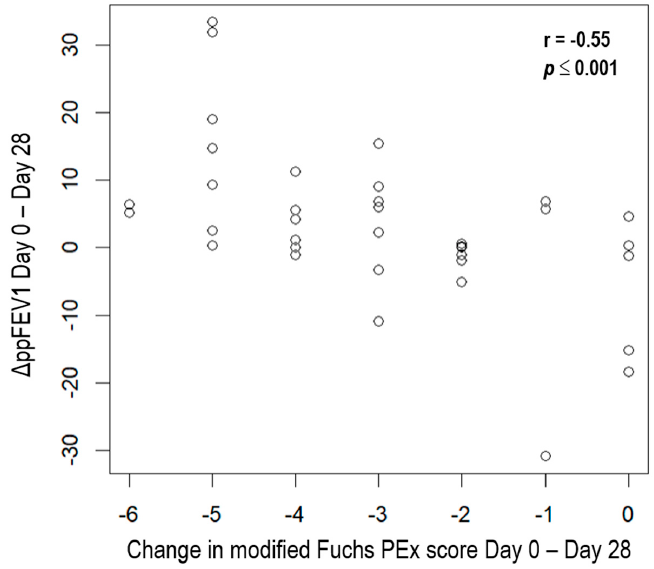
Figure 5. Correlation analysis ∆ ppFEV1/modified Fuchs score (days 0–28).